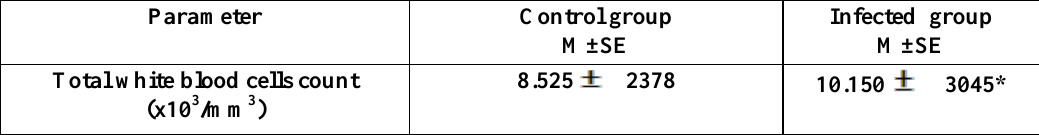
Table (1): Effect of E coli infection on mean of total white blood Cells count.